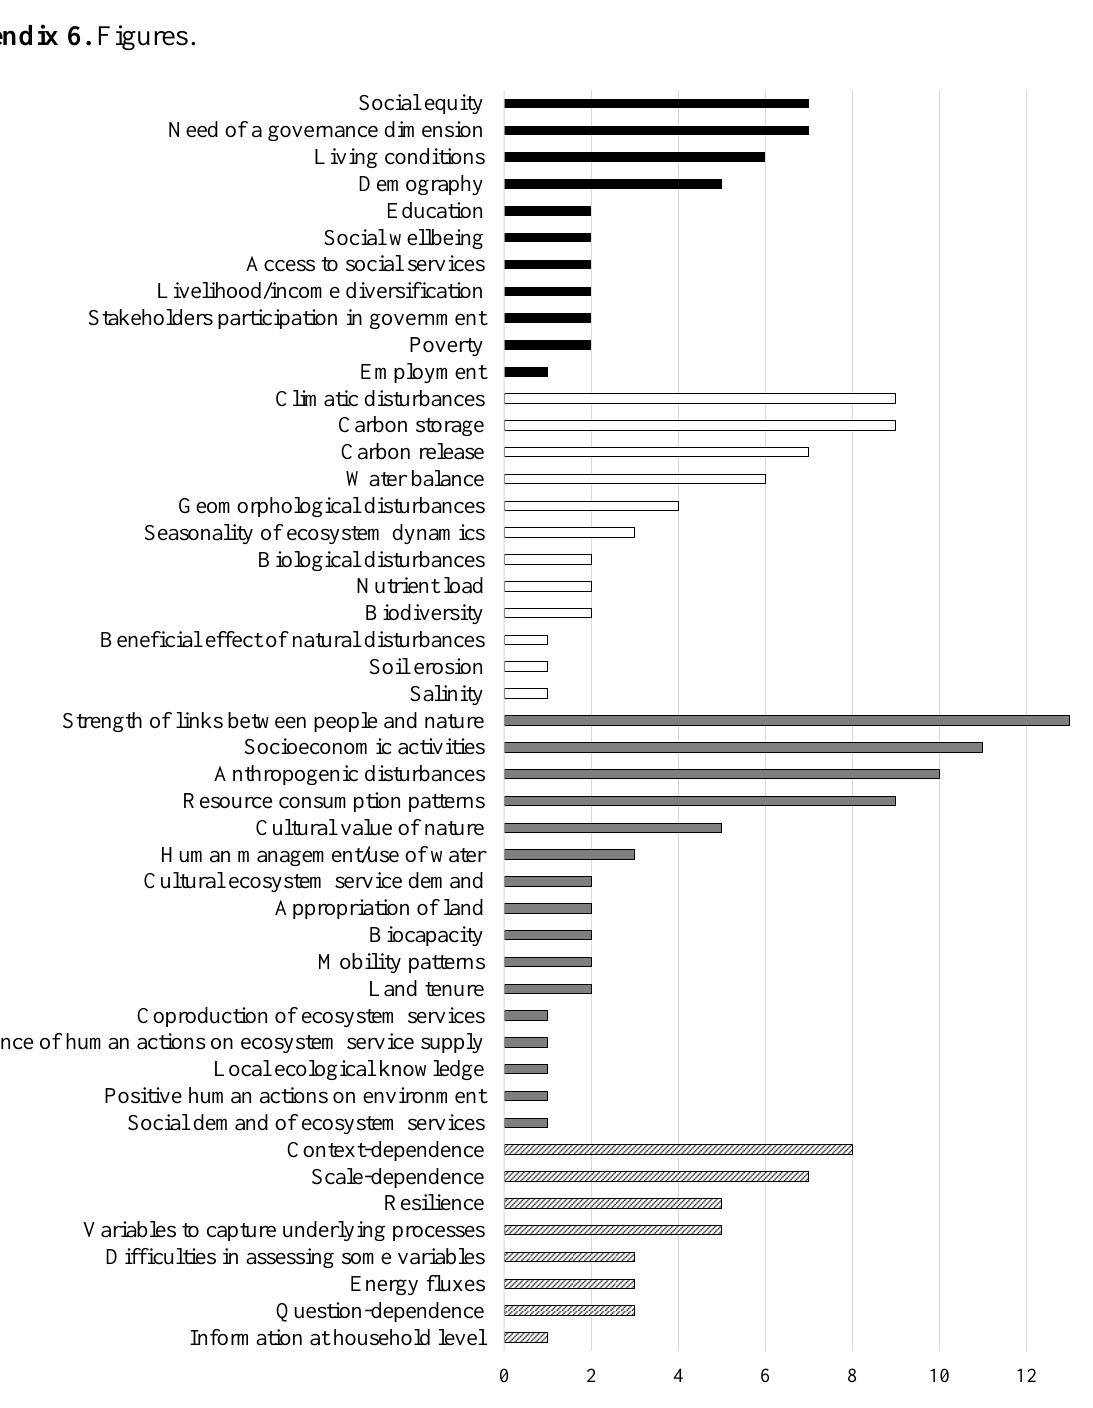
Figure A6.1. Featured topics identified from suggestions and comments in the preliminary survey, which were used to improve the preliminary list of variables and dimensions for characterizing and monitoring SES. Black, white and gray bars represent the social system, ecological system and interaction components, respectively, while stripped bars reflect issues that are transversal to the whole conceptual framework. (See also these topics in the conceptual map of Appendix